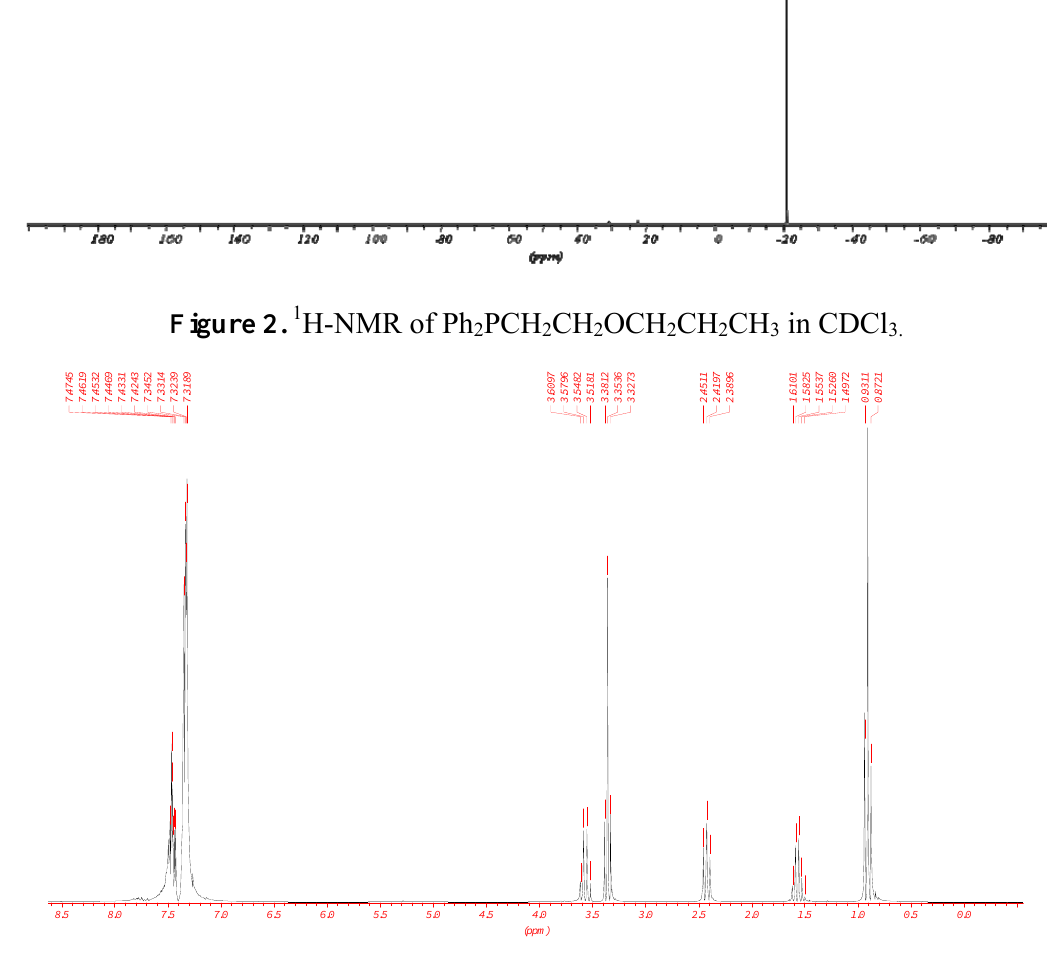
Figure 2. 1 H-NMR of Ph